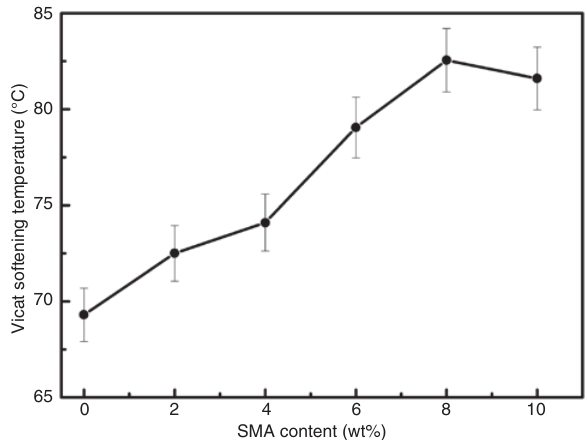
Figure 6 Effect of SMA content on Vicat softening point of the